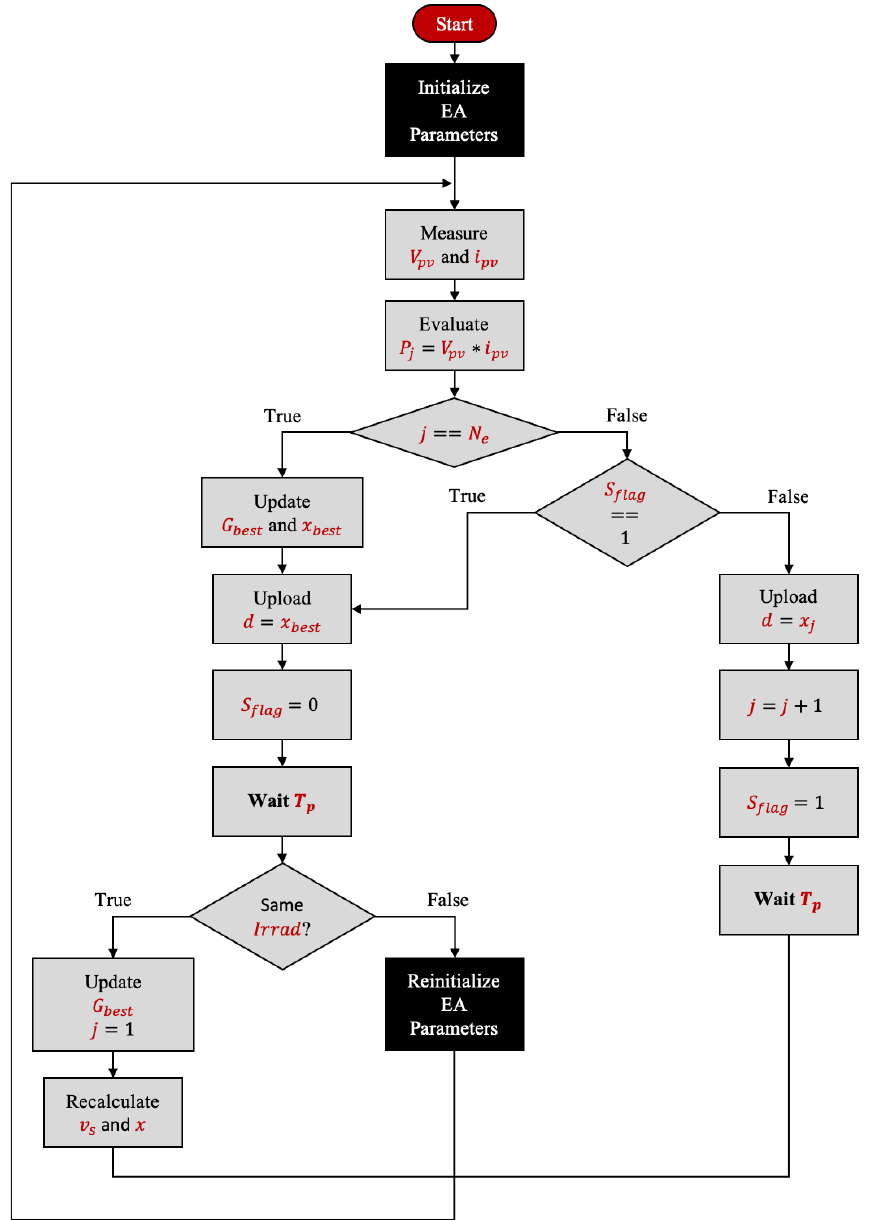
Figure 7. Flow chart of the Earthquake Optimization Algorithm (EA) MPPT